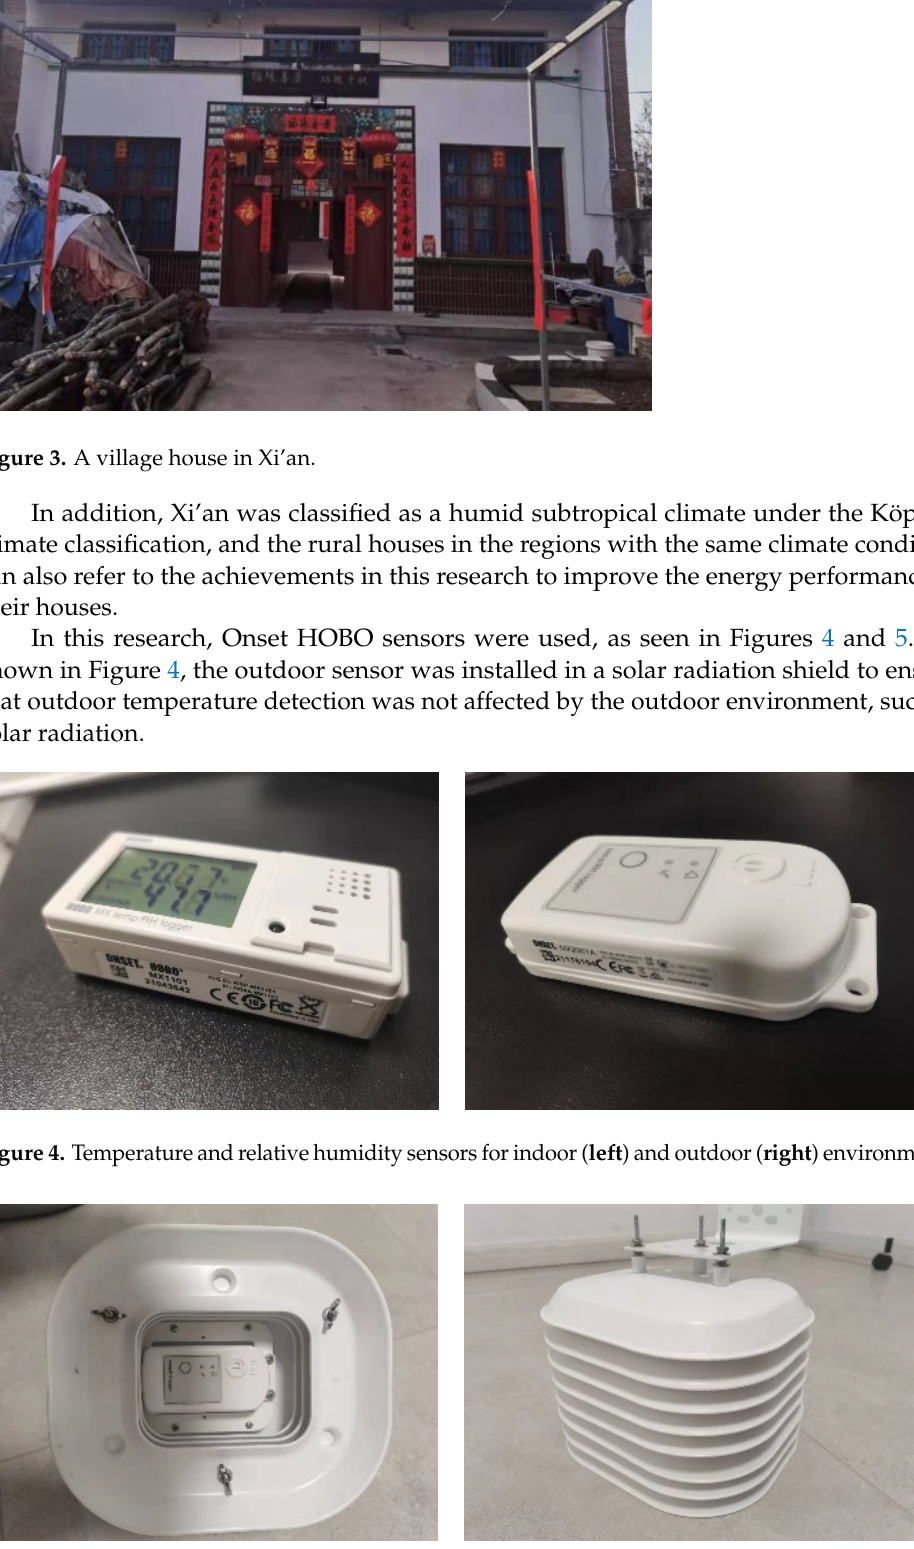
Figure 5. Outdoor temperature and relative humidity sensors (with solar radiation